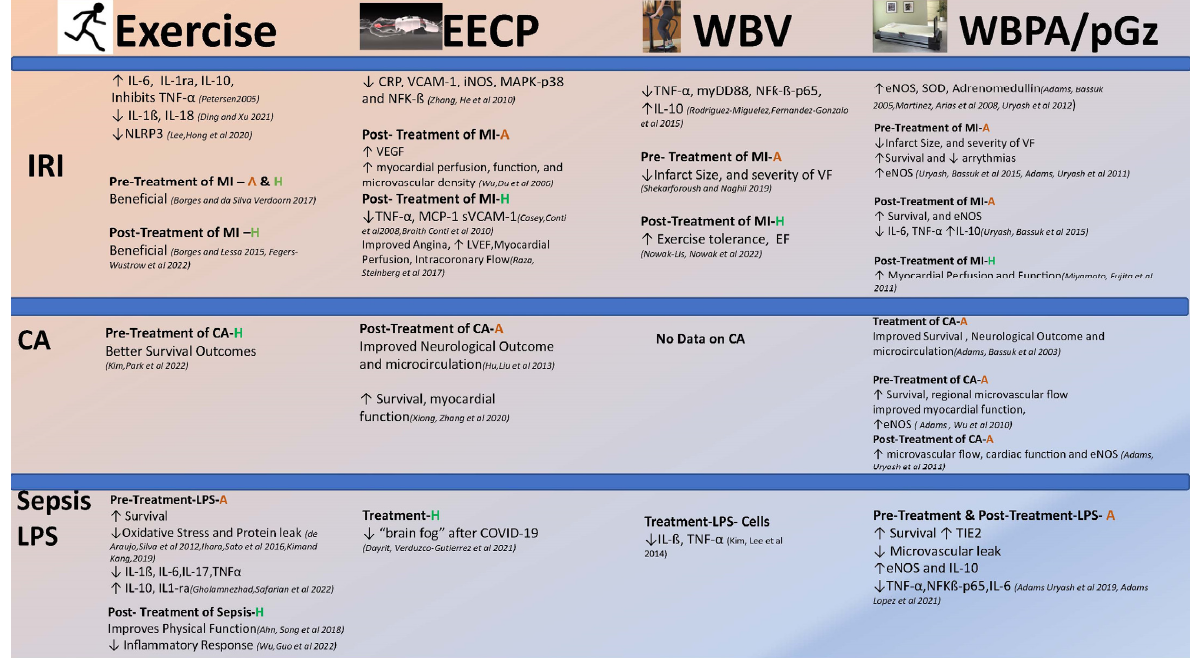
Figure 2. Summary of the Effects of Exercise, Enhanced External Counterpulsation (EECP), Whole- Body Vibration (WBV), and Whole-Body Periodic Acceleration (WBPA also known as pGz) on Ischemia Reperfusion Injury (IRI), Cardiac Arrest (CA), and E. Coli endotoxin induced Sepsis-like syndrome (LPS). Summary table of the effects of four noninvasive methods to induce pulsatile shear stress (PSS), and conditions, that increase endothelial activation and decrease microvascular flow; Ischemia Reperfusion Injury (IRI), cardiac arrest (CA), and sepsis/E. Coli endotoxin induced sepsis like syndrome (LPS). For each intervention, a summary of the changes is provided, when the method to induce PSS is performed as a pretreatment (preconditioning) or posttreatment (postcon- ditioning) strategy, in A (Animals), H (Humans). Abbreviations: ↑ = increase, ↓ = decrease, MI = Myocardial Infarction, VEGF = vascular endothelial growth factor, TNF- α = tumor necrosis factor alpha, IL-1 β = interleukin1-beta, IL-6 = interleukin 6, IL-17 = interleukin 17, IL-10 = interleukin 10, IL1-ra = interleukin 1 receptor antagonist, MCP-1 = Monocyte Chemoattractant Protein-1, sVCAM- 1 = soluble Vascular Cell Adhesion Molecule-1, TIE2 = endothelial-specific receptor tyrosine kinase family, eNOS = endothelial derived nitric oxide synthase, NF ƙ β -p65 = nuclear factor kappa beta p65 subunit, VF = ventricular fibrillation, LVEF = left ventricular ejection fraction, EF = Ejection Fraction. [100–103,114–117,121,122,125,126,128,129,133,134,138–141,143,160–162,166,172,175,177–179,182– 186,188,189] 8. Limitations The review has focused on four of the most published methods for PSS; however, there are other methods. Vibroacoustic Therapy (VAT) is a non-invasive delivery of a sound frequency of 50–100 Hz and a sound pressure of 0.5–20 dyn/cm 2 by a sound speaker that delivers stimulation directed toward the vascular wall. Sound-distributed stimula- tion to the endothelial cell matrix can trigger mechanosensors in cells affected by PSS and has been shown to increase eNO, can induce the expression of the mechanosensory pro- tein Syndecan-4 (Syn4) and VEGF, as well as increase blood flow and clot dissolution [196–200]. This method may also be a plausible therapeutic strategy for MI [201,202] and sepsis [203]. Additional methods of delivering PSS also include passive cycling or limb movement [204,205], as well as a recently published method of 160-degree V-shaped WBPA in supine posture [206]. The latter methods may also have potential for clinical therapeutics, but